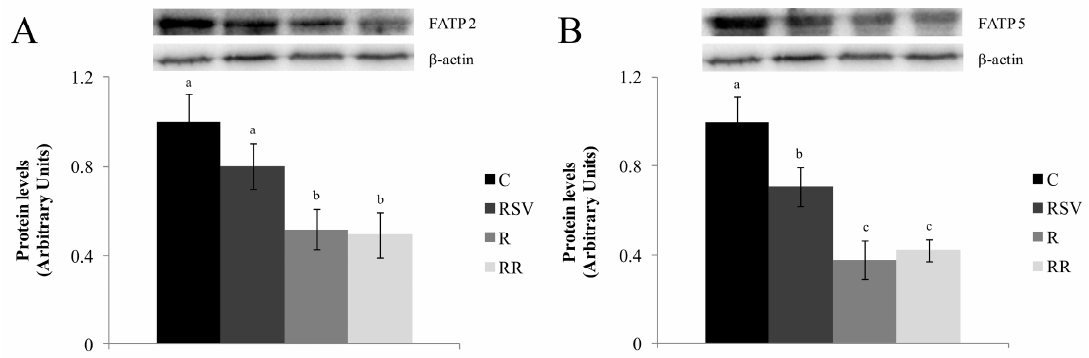
Figure 5. FATP2 ( A ) and FATP5 ( B ) protein expression in liver from rats fed an obesogenic diet for six weeks, and then fed a standard diet (C), or a standard diet supplemented with resveratrol (RSV), or submitted to energy restriction and fed a standard diet (R) or submitted to energy restriction and fed a standard diet supplemented with resveratrol (RR) ( n = 9/group) for additional six weeks. Values are mean ± SEM. Differences among groups were determined by using one-way ANOVA followed by Newman Keuls post-hoc test. Values not sharing a common letter are significantly different ( p < 0.05). FATP2: fatty acid transport protein 2, FATP5: fatty acid transport protein 5.